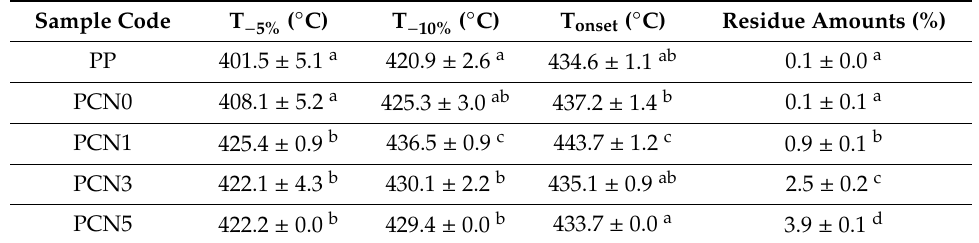
Table 3. Thermal properties of PP, PP / CNF, and PP / CNF / nanoclay nanocomposites. Sample